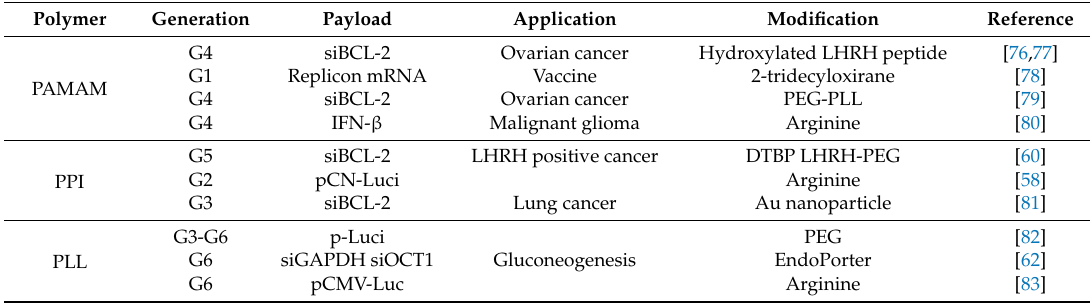
Table 2. Examples of dendrimer-based nanosystems as vehicles for nucleic acid